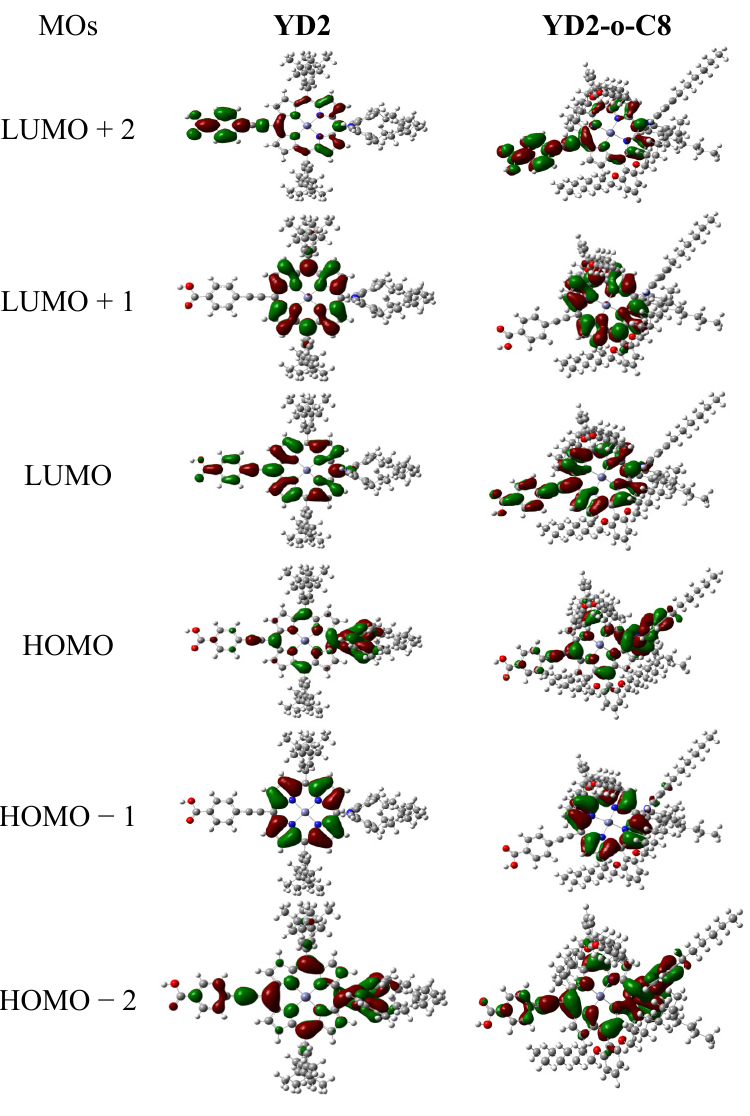
Figure 4. Isodensity plots (isodensity contour = 0.02 a.u.) of the frontier orbitals of the dye YD2 and